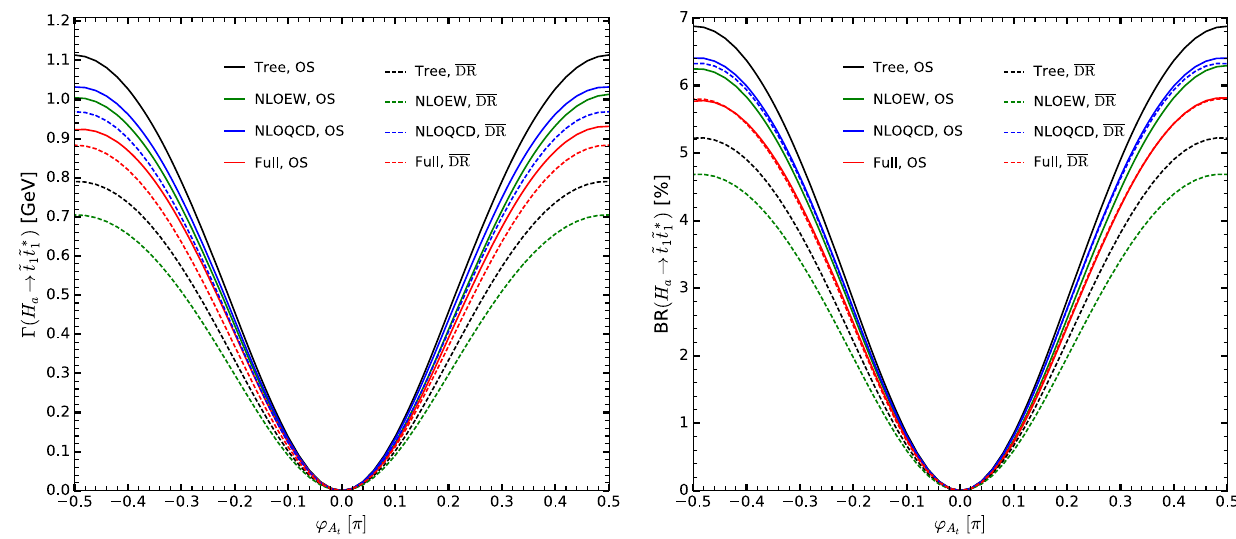
Fig. 11 Scenario2: Tree-level (black), NLO EW (green), NLO QCD (blue) and full (red) partial width (left) and branching ratio (right) of the decay H